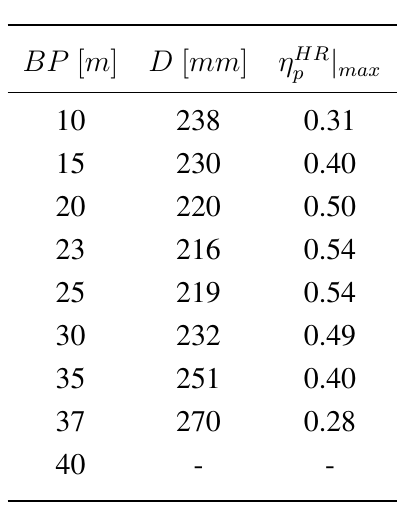
Table 1. VOS in ER mode